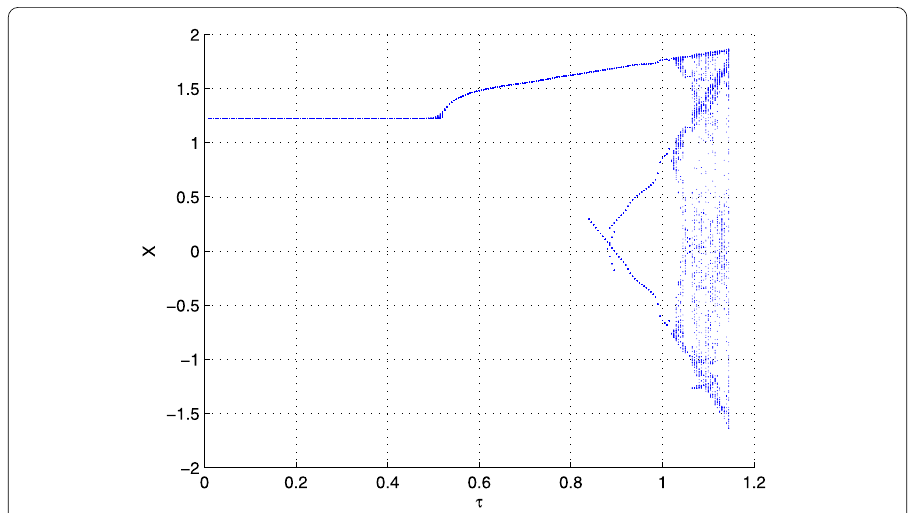
Figure 6 The bifurcation diagram of system (17) with the parameter γ = 1.5